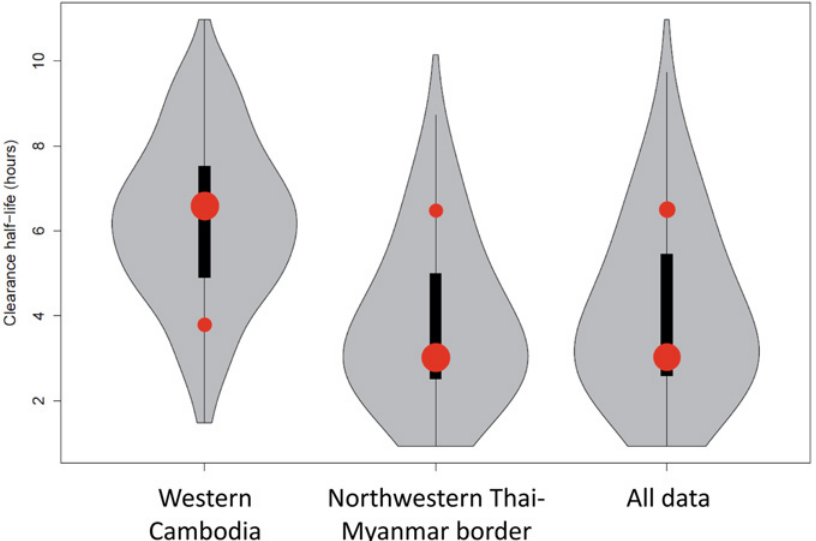
Fig 3. Plot of the model fits (red dots) to observed data (grey violin plots, with a black bar representing the interquartile range) aggregated by country. Number of dots per site indicates the number of contributing distributions. The position of the dot on the y-axis represents the geometric mean of the distribution and the size of the dot represents the relative contribution of that subgroup to the full distribution.